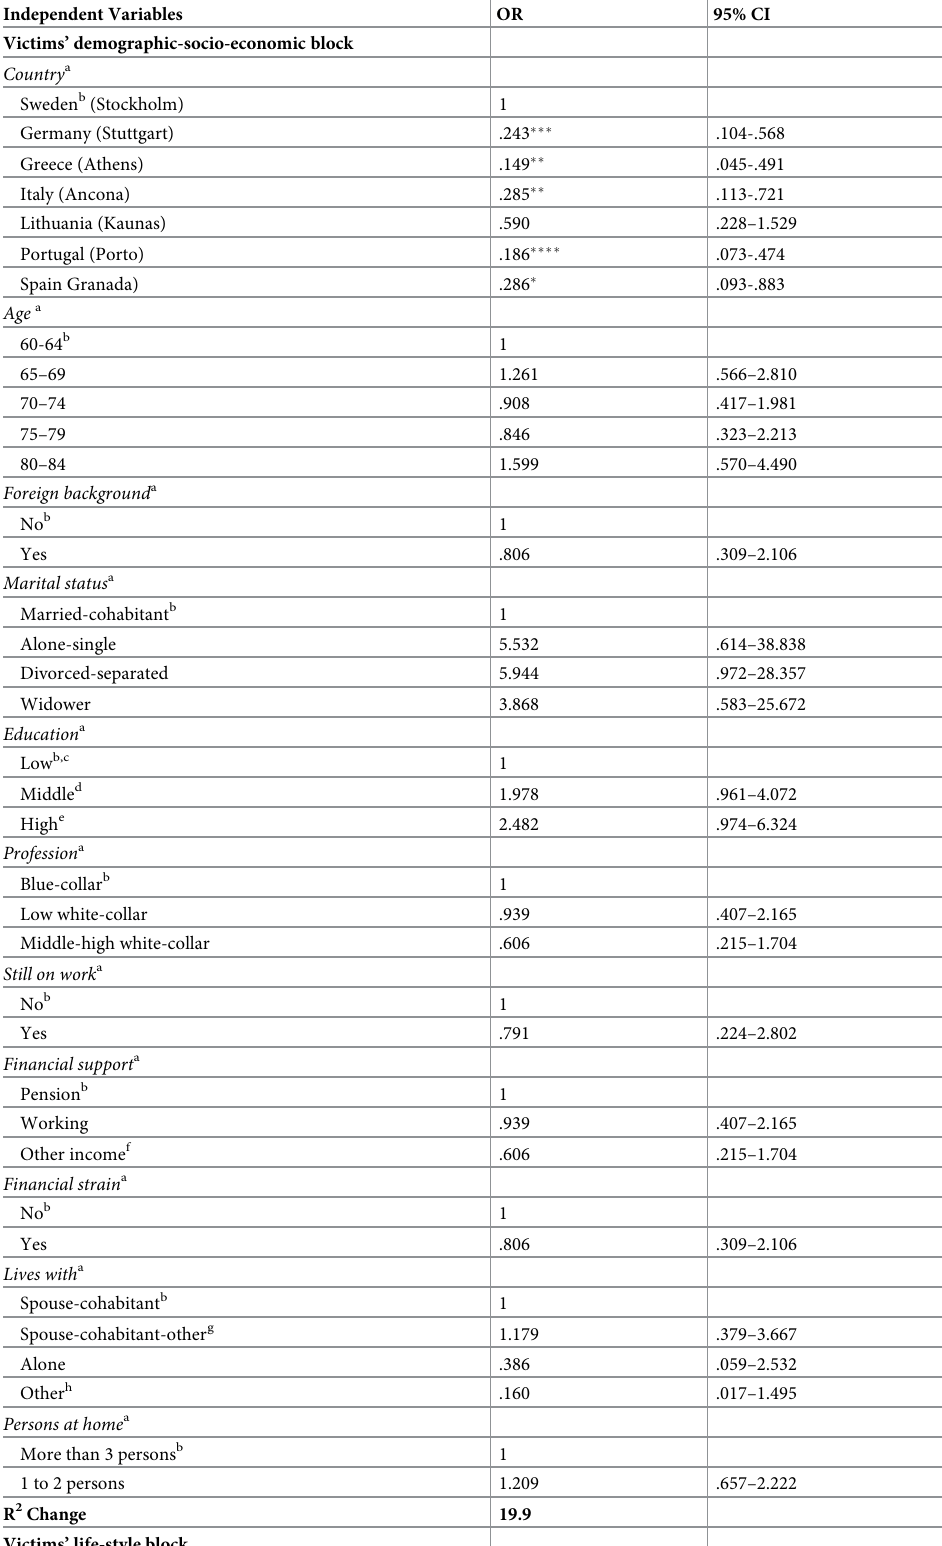
Table 3. Factors associated with total high chronicity of any abuse among older men (n = 1719). Independent